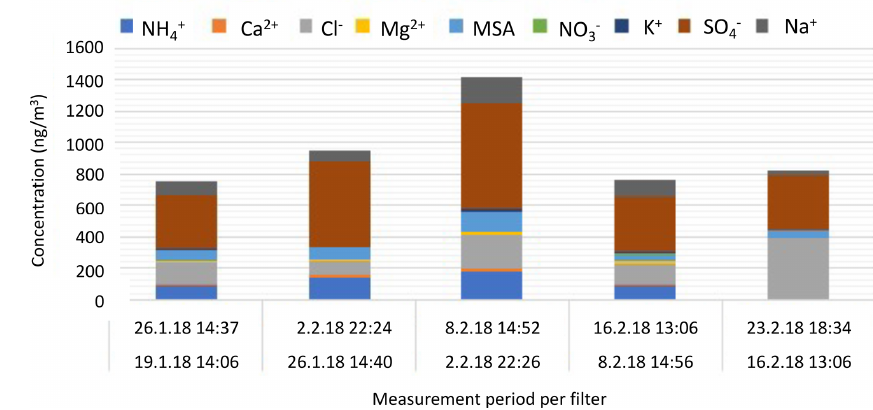
Figure 8. Chemical composition of water-soluble ions from weekly fine-aerosol samples (PM 2 . 5